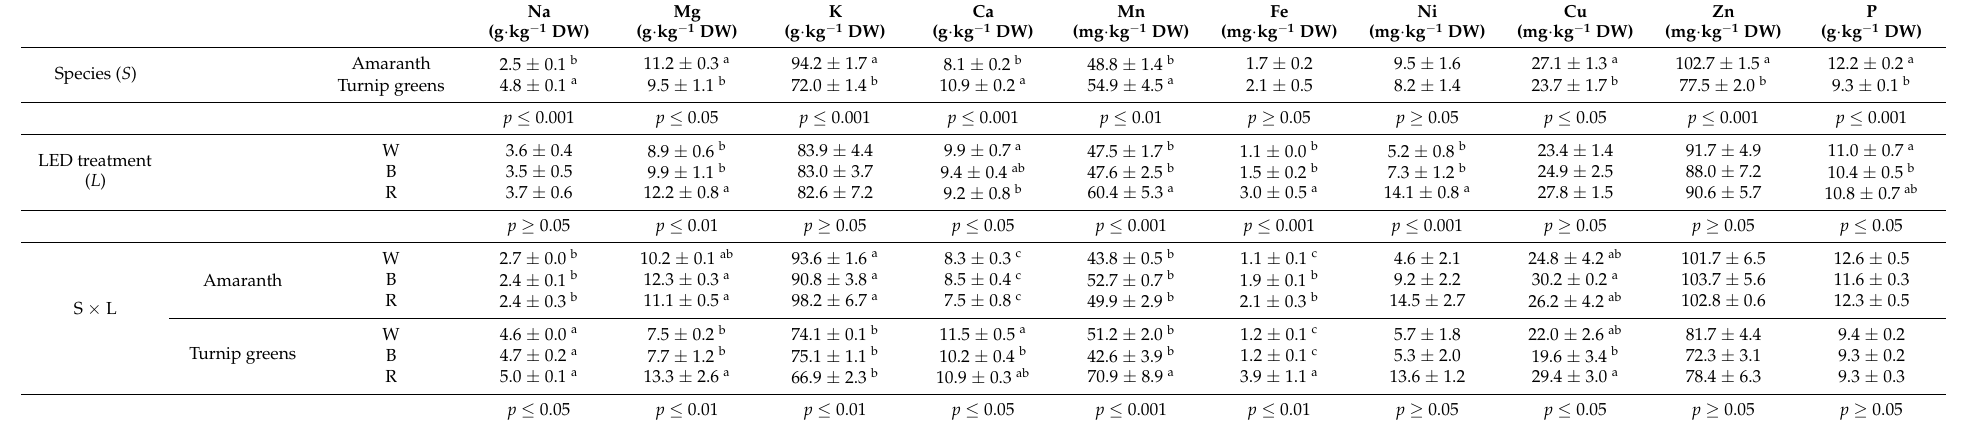
Table 5. Results of the multifactorial ANOVA for sodium (Na), magnesium (Mg), potassium (K), calcium (Ca), manganese (Mn), iron (Fe), nickel (Ni), copper (Cu), zinc (Zn), and phosphorus (P) concentrations of